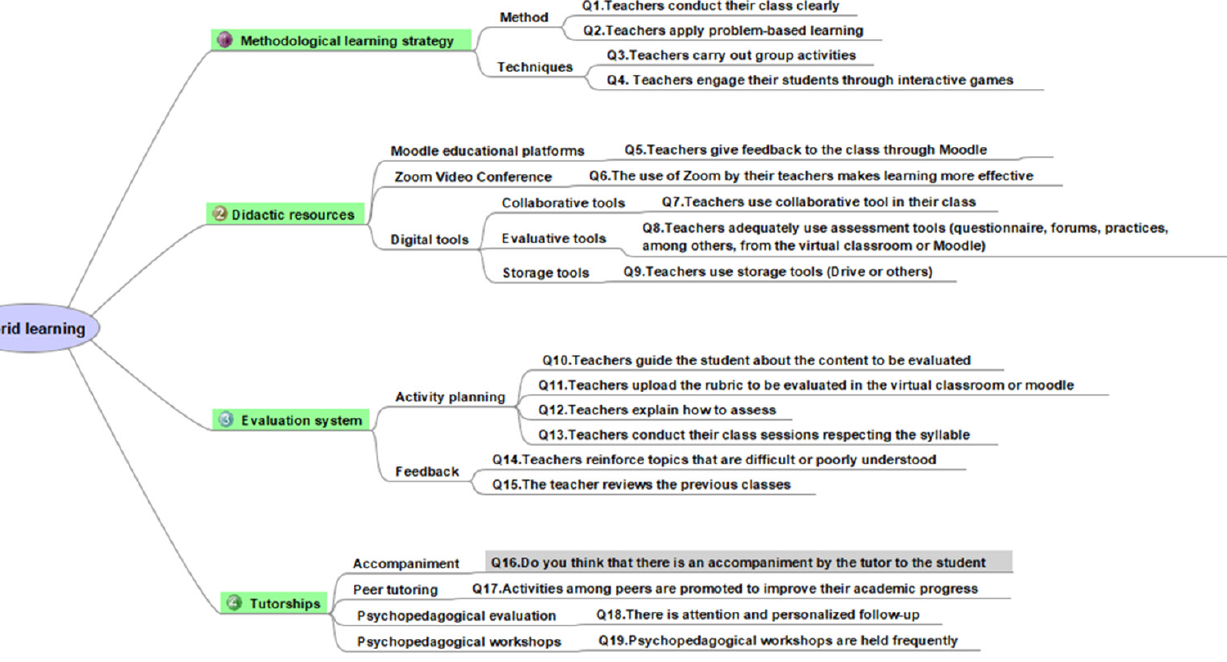
Fig. 1. Dimensions of the